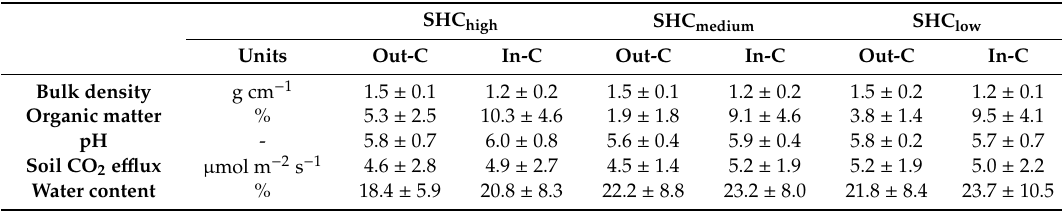
Table 1. Mean ± standard deviations of soil parameters. SHC indicates the “soil habitat condition” categories; In-C and Out-C indicate whether values were detected beneath the tree canopy or outside the canopy, respectively.